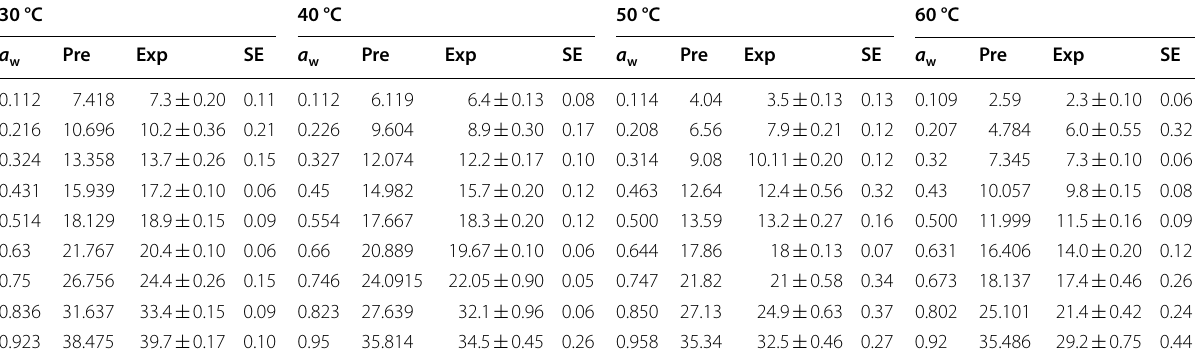
Values are mean of 3 determinations